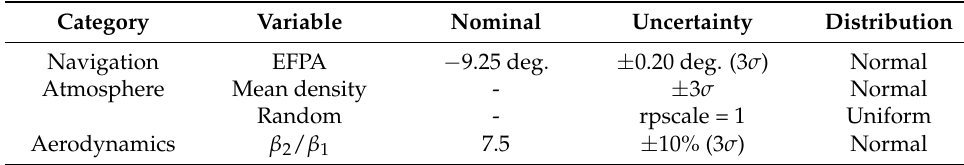
Table 4. Mars aerocapture Monte Carlo